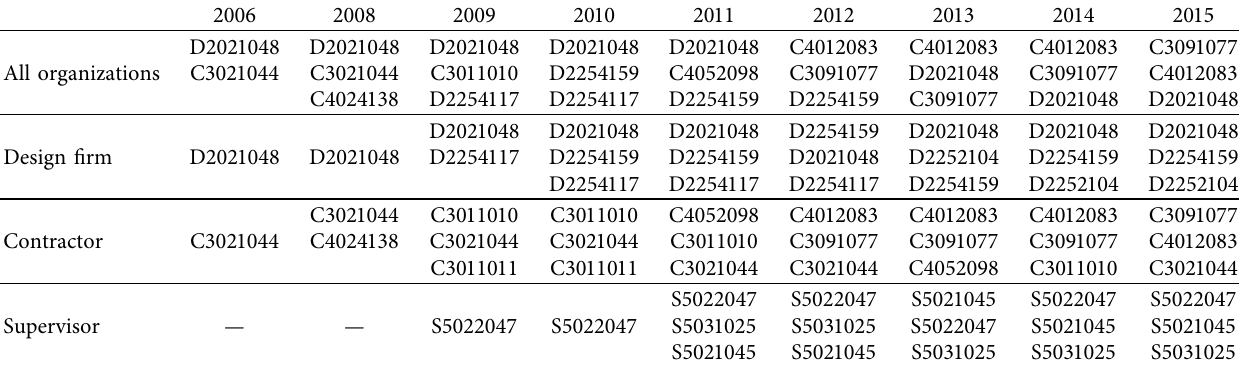
Table 6: Organisations of first-tier betweenness centrality (top 3) each